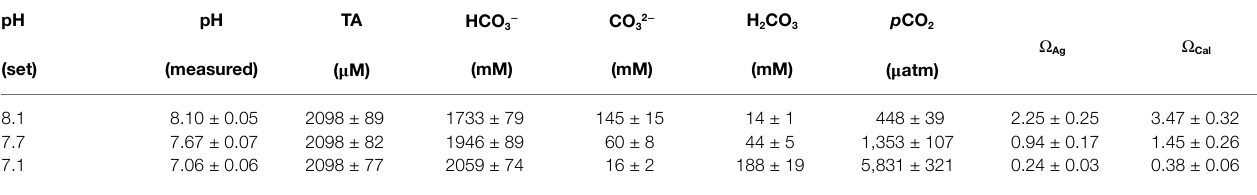
TABLE 1 | Key parameters (means ± SD, n = 3) of carbonate chemistry in CO 2 enriched seawater of different pH levels, including setting seawater pH, measured pH, total alkalinity (TA), concentrations of bicarbonate (HCO 3 − ), carbonate ion (CO 32 − ), carbonic acid (H 2 CO 3 ), and partial CO 2 pressure ( p CO 2 ), calculated saturation states of aragonite ( Ω Ag ), and calcite ( Ω Cal